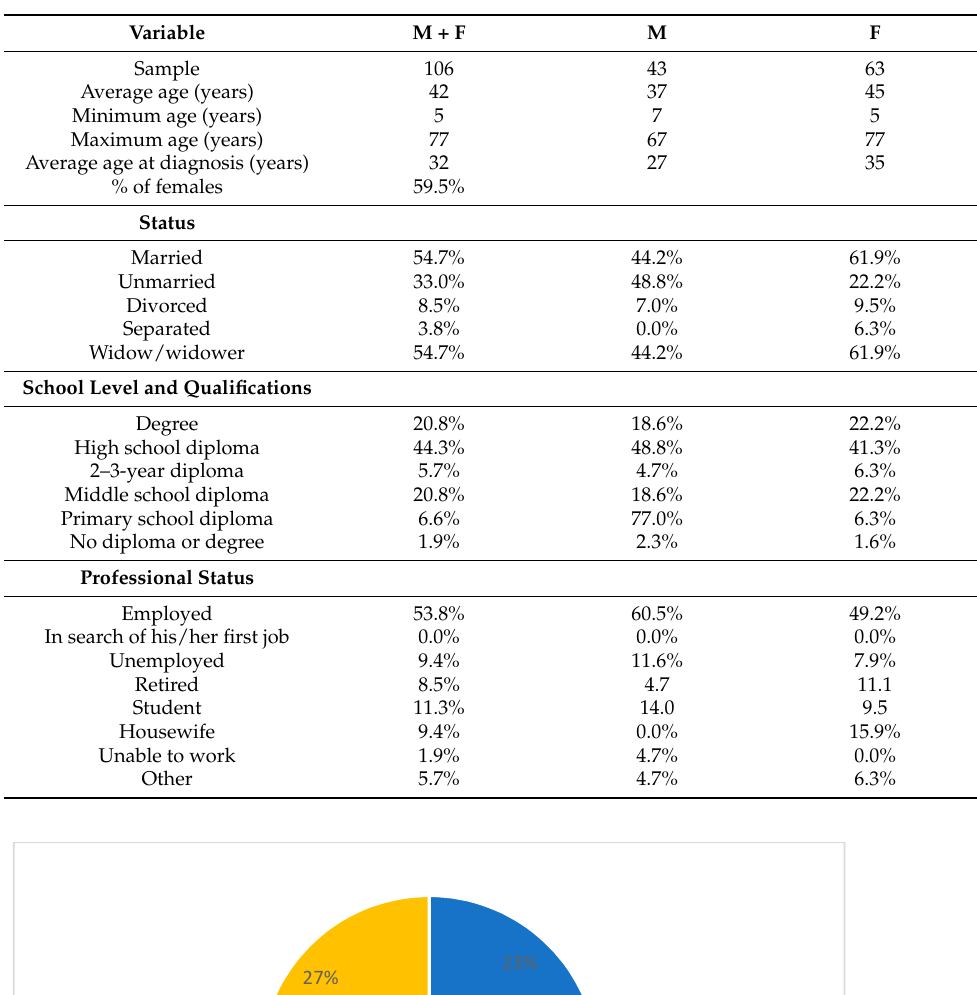
Table 1. General characteristics of patients with Fabry disease considered in the study.